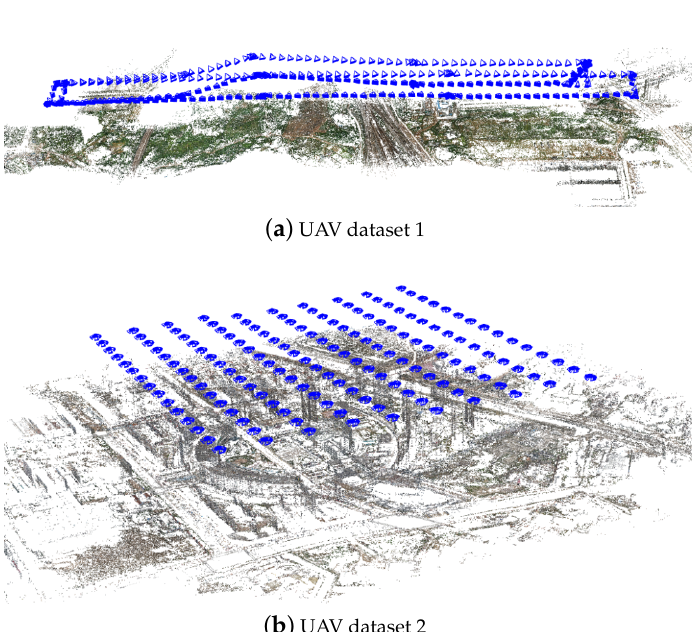
Figure 22. The SfM-based image orientation by using the matching results from the proposed algorithm. Blue rectangles represent the oriented camera frames, and 3D points are rendered by using true image